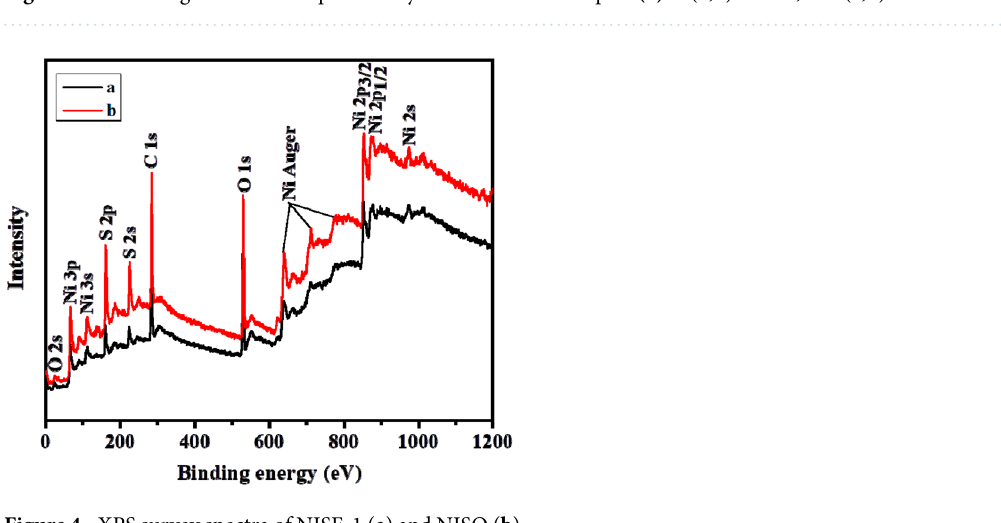
Figure 4. XPS survey spectra of NISE-1 ( a ) and NISO ( b